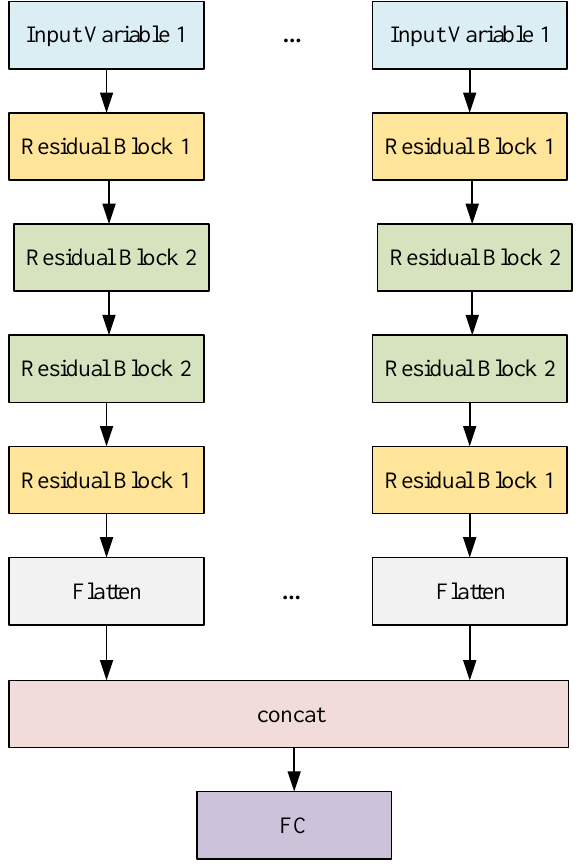
Figure 7. An overview of the M-TCN network.